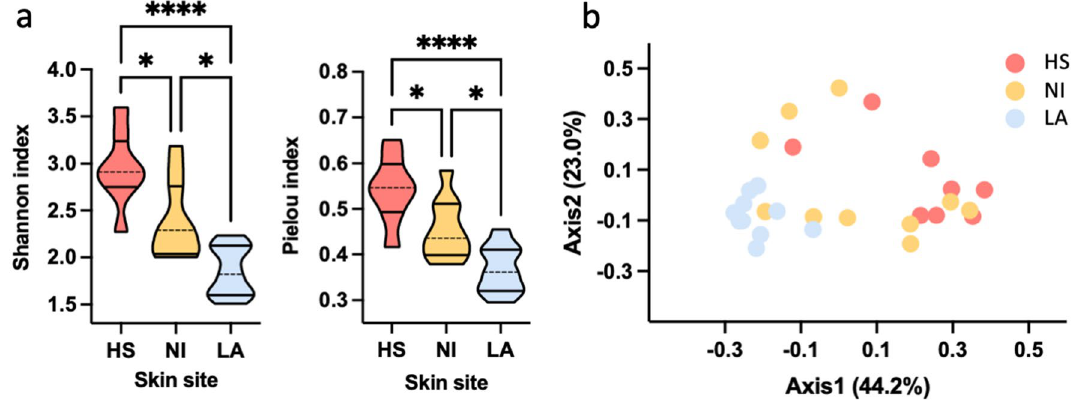
Figure 1. Loss of diversity characterizes inflammatory acne. Skin microbiota was evaluated on samples collected from the skin of ten healthy subjects (HS) and non-inflammatory (NI), and inflammatory lesions (LA) of ten acne patients. ( a ) Alpha diversity was calculated using the Shannon diversity index (HS vs. NI, P = 0.0209; HS vs. LA, P < 0.0001; LA vs. NI, P = 0.0118) and Pielou Evenness index (HS vs. NI, P = 0.0241; HS vs. LA, P < 0.0001; LA vs. NI, P = 0.0136). Statistical differences were determined using the Kruskal–Wallis test. ( b ) Bray Curtis beta diversity was calculated at the genus level and represented as principal coordinate analysis